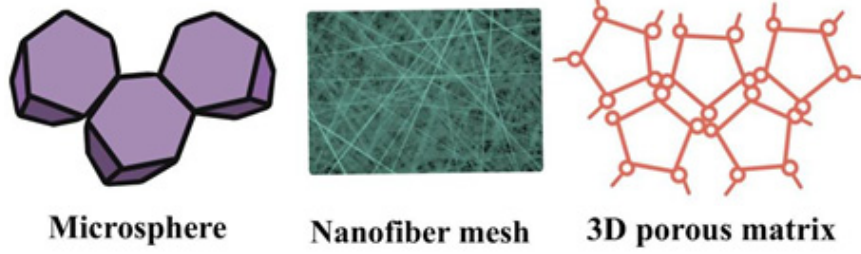
Figure 6. Different types of biopolymeric scaffolds.